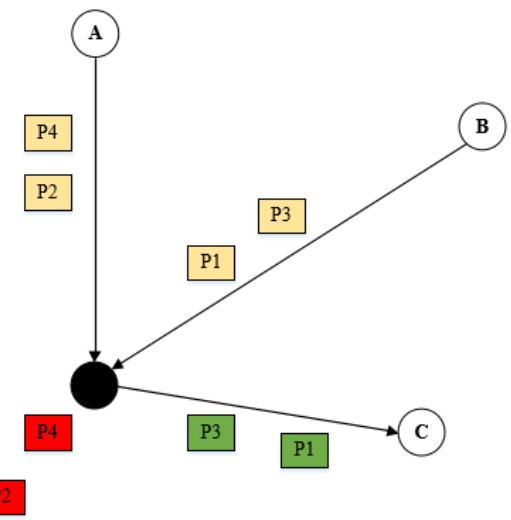
Figure 7. Demonstration of a Selective Forwarding Attack.